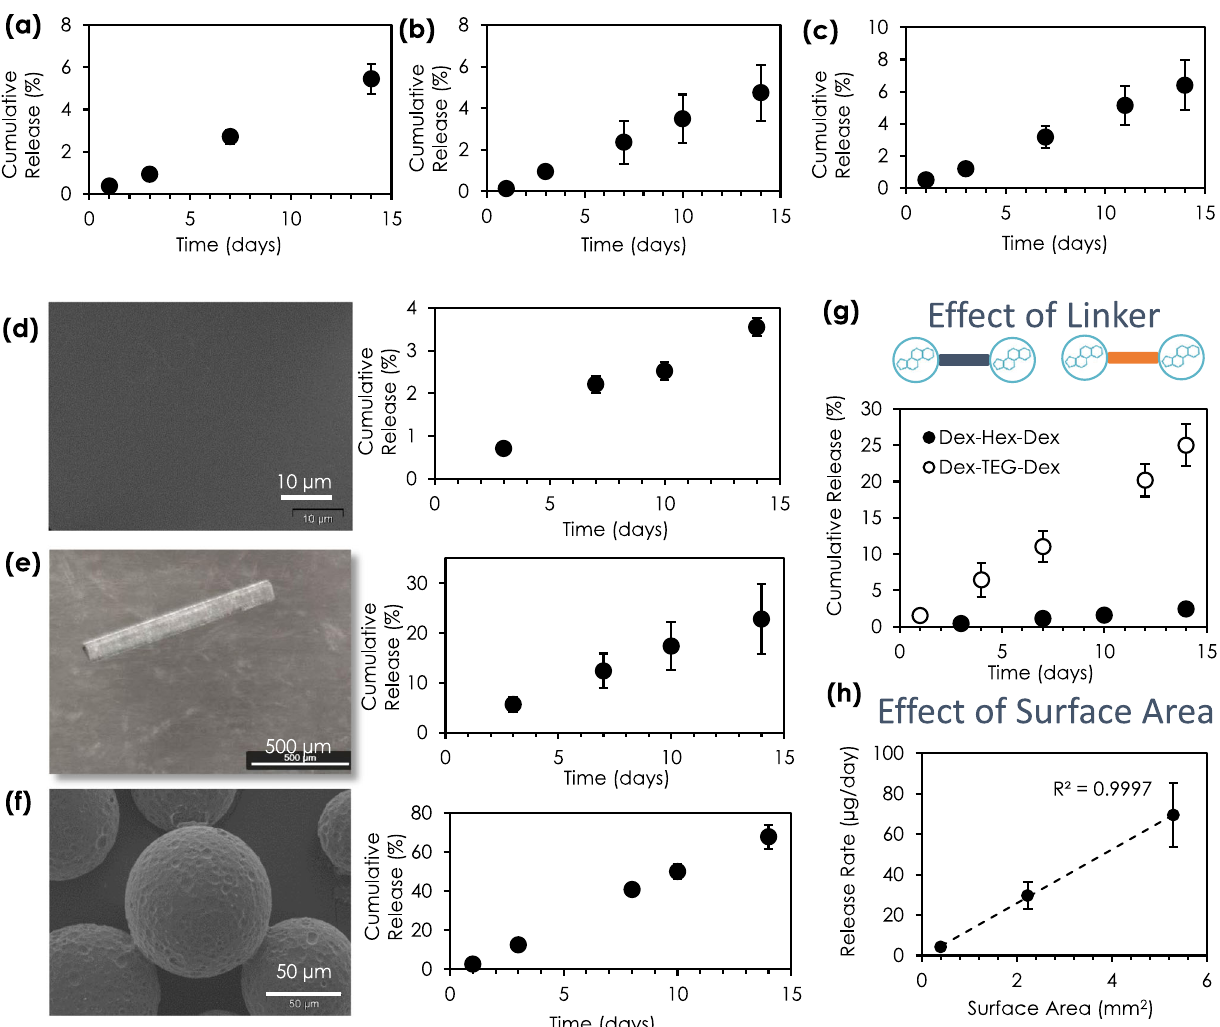
Fig. 5 Versatility of the dimer material platform to achieve rational design. Release kinetics of heat-molded 1 mm×1 mm (height x diameter) pellets for free a prednisolone (Pred) from Pred-TEG-Pred (N = 3 samples, TEG – triethylene glycol) in 4 ml phosphate buffered saline (PBS) (0.96 ± 0.1 mg Pred loading), b triamcinolone acetonide (TA) from TA-TEG-TA ( N = 5 samples) in 4 ml FBS (0.81 ± 0.18 mg TA loading), and c hydrocortisone (HC) from HC- TEG-HC in 4 ml PBS (0.60 ± 0.08 mg HC loading) (N = 3 samples). Scanning electron micrograph (SEM) images and release curves demonstrating free drug release for dimers processed into d coatings (4 ml PBS, 0.78 ± 0.03 mg dexamethasone (Dex) loading, 12 mm diameter circular coating) ( N = 3 samples), e extruded rods (4.4 ml PBS, 17.7 ± 4.4 µ g Dex loading) ( N = 3 samples), and f microparticles (10 ml fetal bovine serum (FBS), 42.2 ± 18.2 µ m diameter, 0.12 ± 0.01 mg TA loading) ( N = 3 samples). For coatings, the SEM image indicates a smooth coating surface at high magni fi cation. g Release rate in FBS for free Dex from Dex dimers with either a TEG or hexane diol (Hex) linker (2 ml, 1 mm×1 mm height x diameter pellets, 1.39 ± 0.27 mg Dex loading for Dex-Hex-Dex and 0.51 ± 0.05 mg for Dex-TEG-Dex) (N = 3 samples). h Correlation between release rate and surface area for implants in FBS (1.5 ml FBS, 23 G × 6 mm − 348 ± 141 µ g loading, 30 G × 1 mm – 11 ± 2 µ g loading, 30 G × 6 mm – 63 ± 16 µ g loading). N = 3 samples. In all panels, data represent the mean ± standard